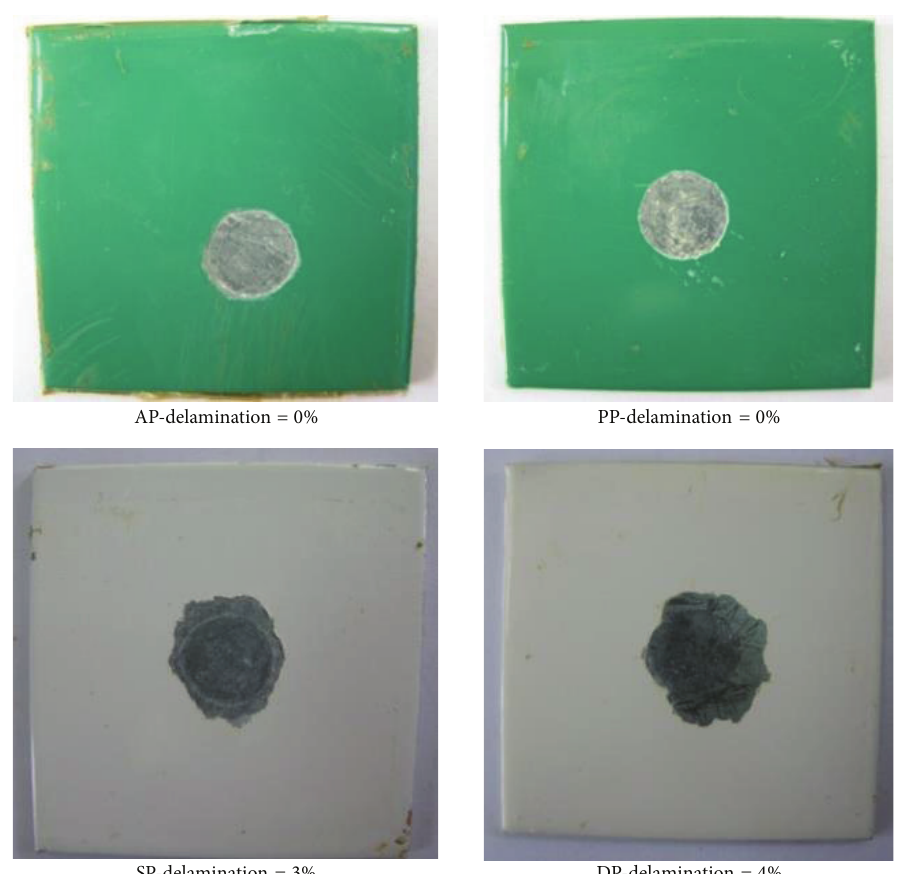
Figure 6: Delamination of primer/topcoat system applied on hot-dip galvanized steel after 15 days of exposure in 5% NaCl solution.